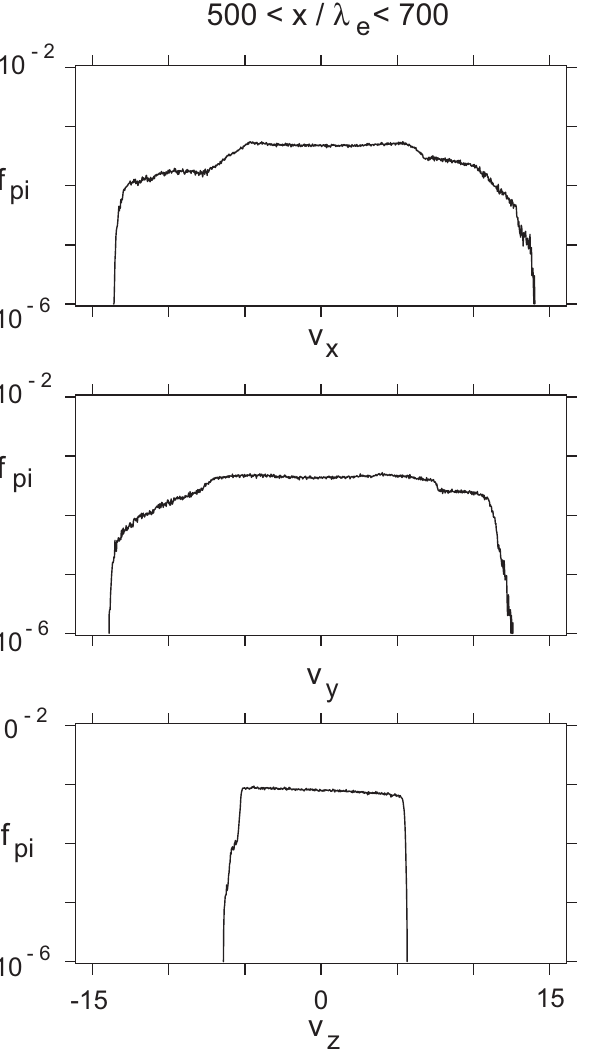
Fig. 7. Reduced pickup proton distribution functions downstream of the shock averaged over 200 λ e . From top to bottom is shown f pi (v x ) , f pi (v y ) , and f pi (v z ) .